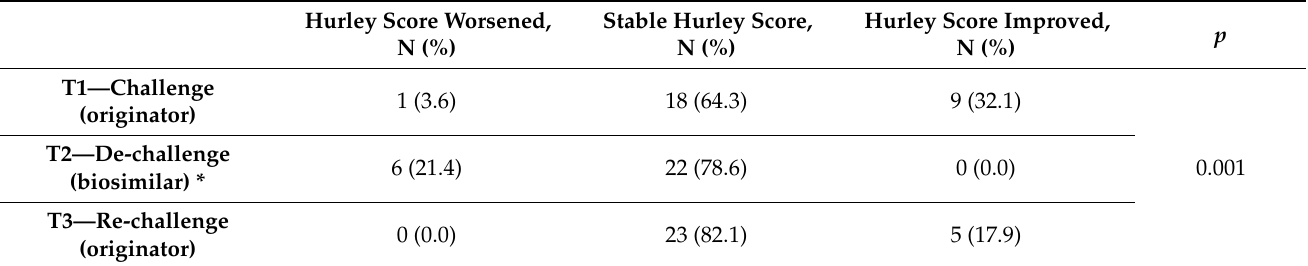
Table 2. Hurley score trend of 28 patients with a lack of improvement after switching from originator to